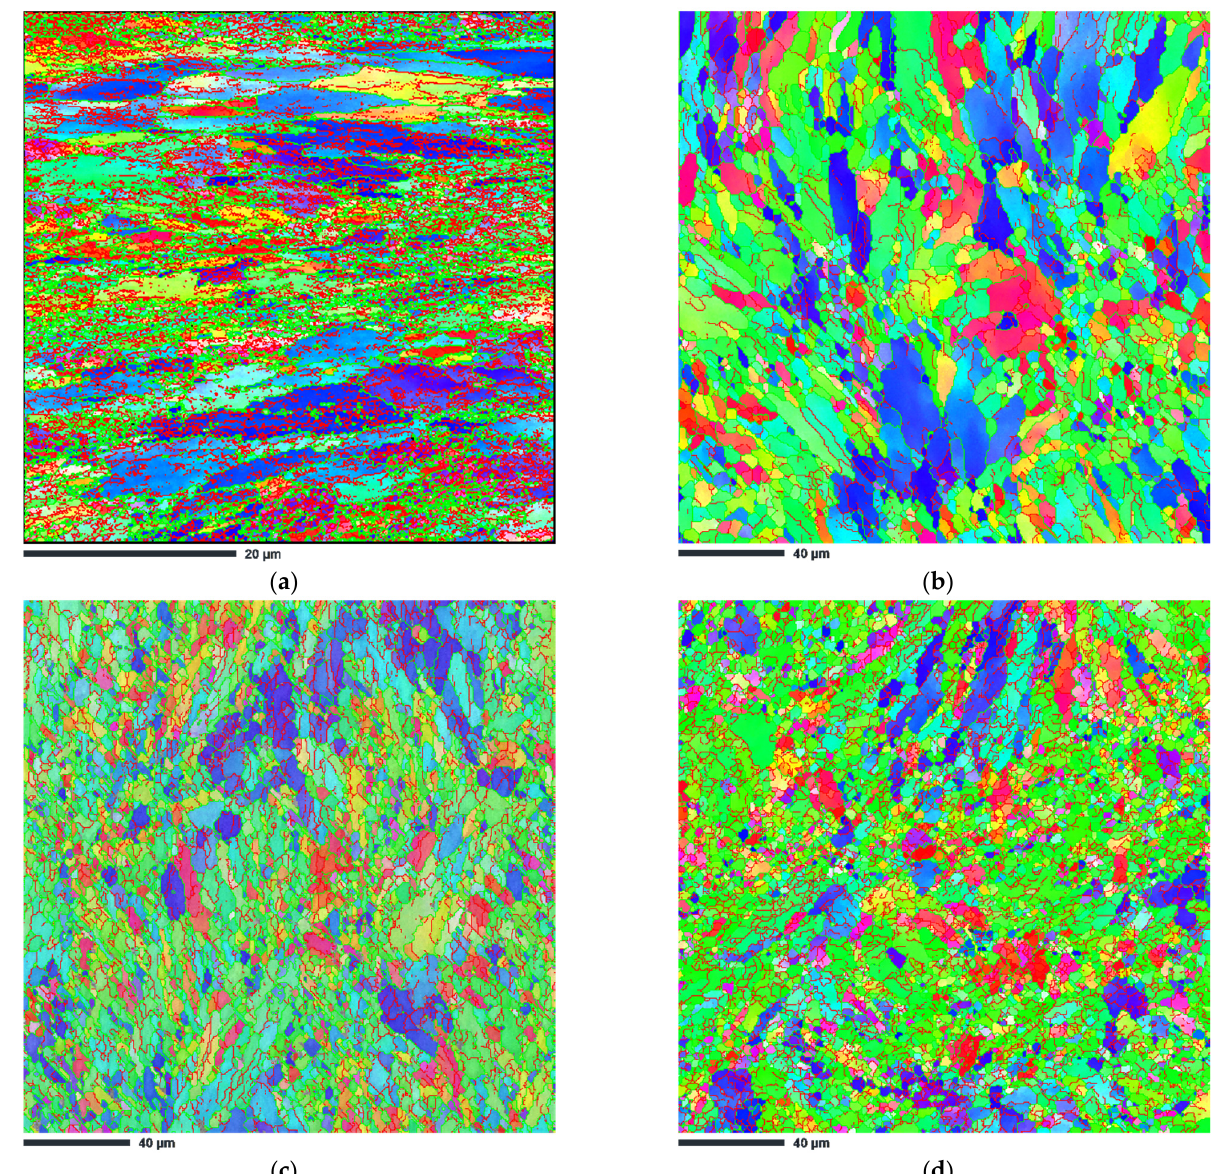
Figure 7. SEM IPF ‐ Z images of ECAP ‐ processed samples ( a ) HT280E150; ( b ) SLME350; ( c ) SLME400; Figure 7. SEM IPF-Z images of ECAP-processed samples ( a ) HT280E150; ( b ) SLME350; ( c ) SLME400; ( d ) SLME450. ( d )